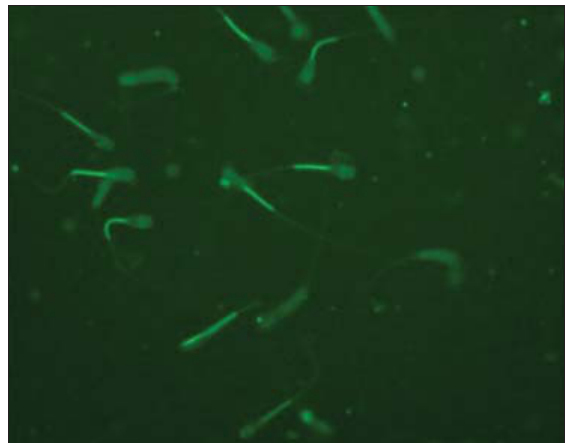
Figure-3: Sperm mitochondria stained with TMRM, FITC filter (400x).